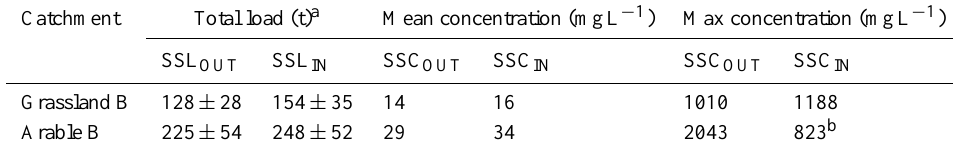
Table 3. Suspended sediment metrics estimated using in situ and ex situ turbidity-based SSC estimation methods. Catchment